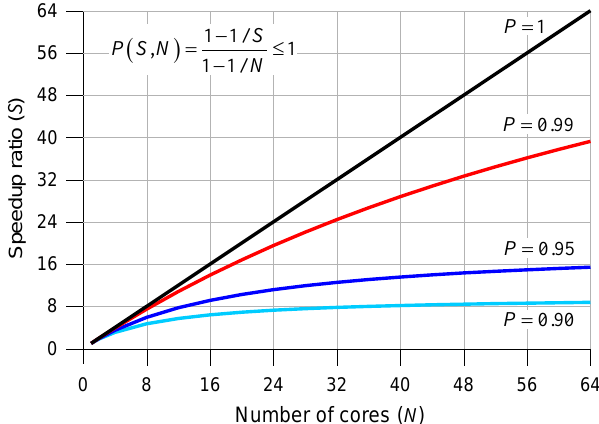
Figure 9. Speedup ratio S according to Amdahl ’ s law.